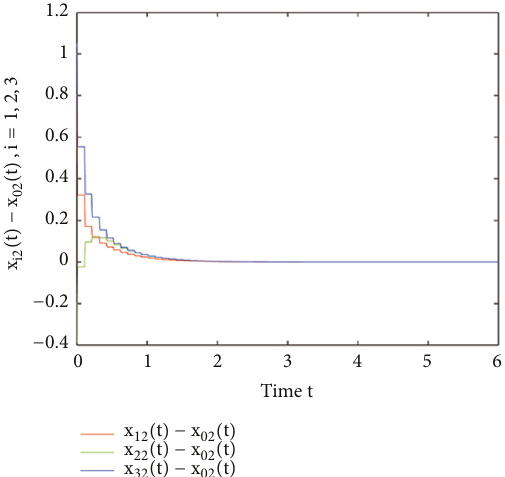
Figure4:The 2 -dimensionalerrorvalueofagent 𝑥 𝑖 andleaderagent 𝑥 0 .